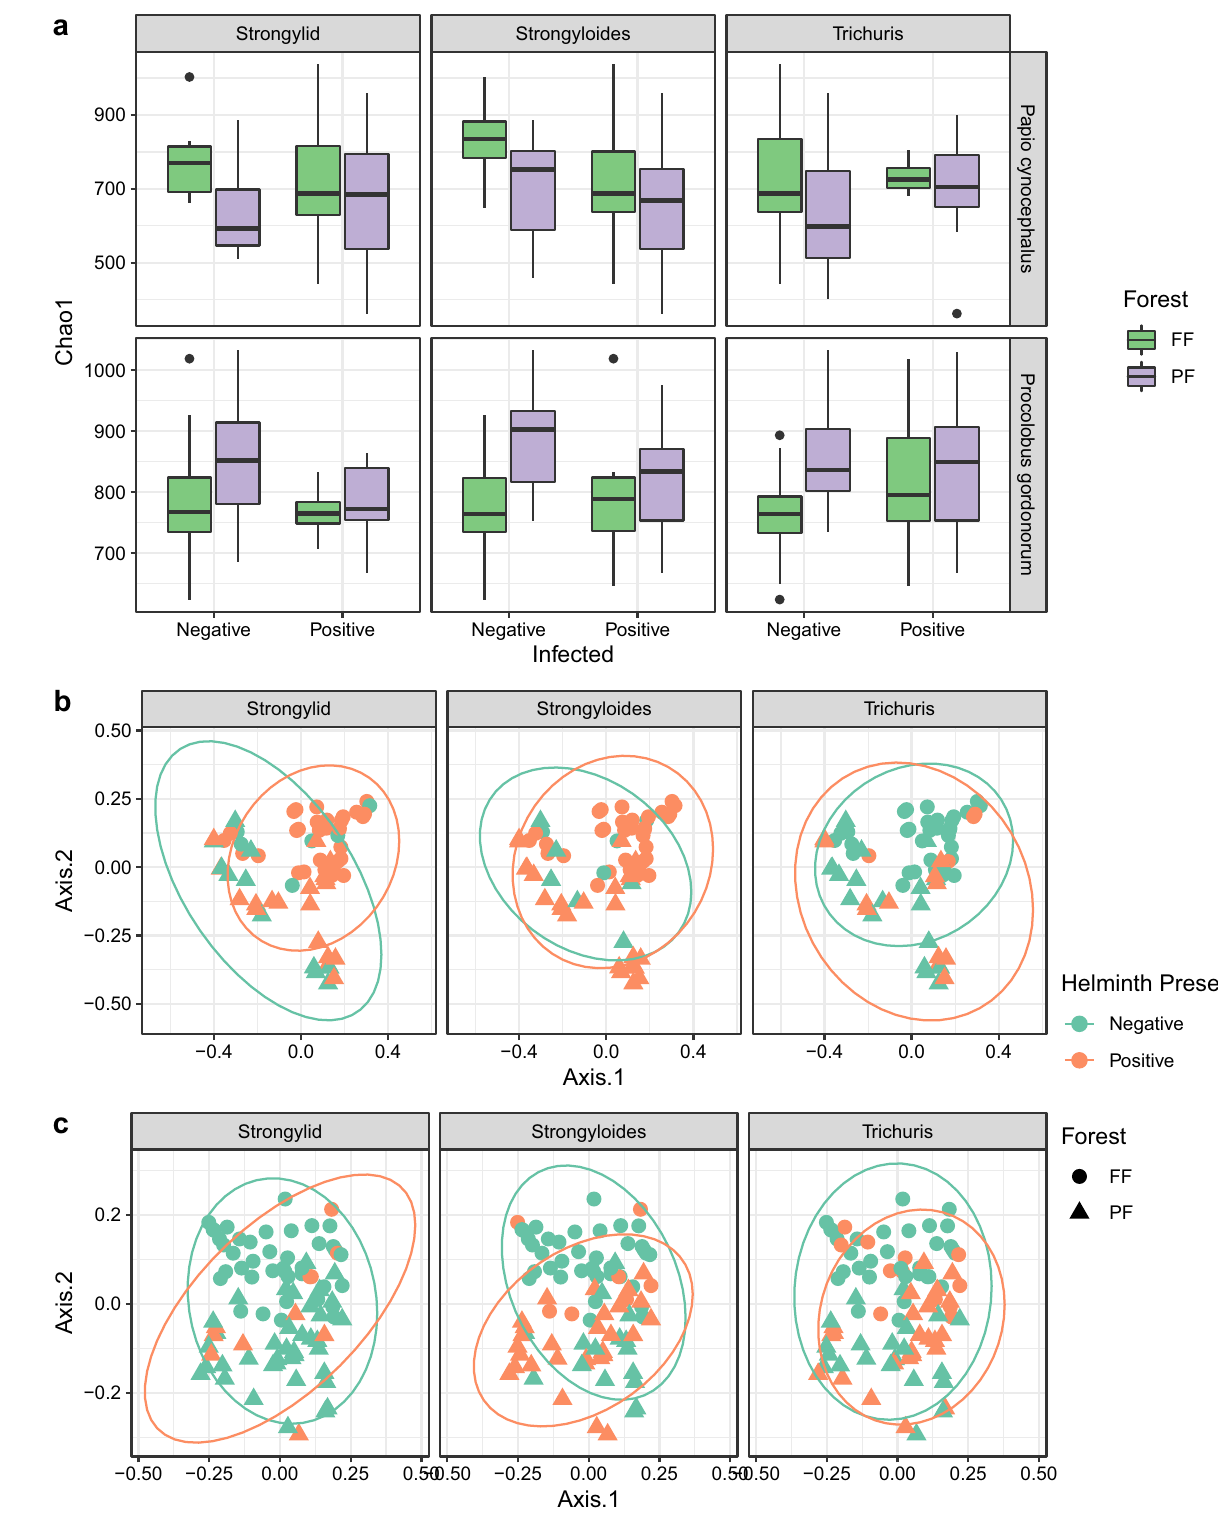
Figure 1. Diversity of gut bacterial communities in yellow baboons and Udzungwa red colobus in two forest types. ( a ) Comparison of bacterial richness measured by Chao1 estimator and ( b , c ) bacterial composition measured by Bray–Curtis dissimilarities for helminth negative and positive faecal samples. Panels from left to right focus on three helminth taxa: strongylid nematodes, Strongyloides , and Trichuris present in yellow baboons, Papio cynocephalus [upper panel in ( a ); ( b )], and Udzungwa red colobus monkeys, Procolobus gordonorum [bottom panel in ( a ); ( c )], living in the forest fragment of Magombera [FF: green in ( a ), circle in ( b ) and ( c )] or the protected forest of Mwanihana [PF: purple in ( a ); triangle in ( b ) and ( c )] in the Udzungwa Mountains of Tanzania. In ( a ), the horizontal line in the boxplot indicates the median, the box extends to the 25th–75th percentile and the whiskers extends to the largest value no further than 1.5 * IQR from the hinges. In ( b ) and ( c ) colours represent helminth negative (green) and positive (orange)